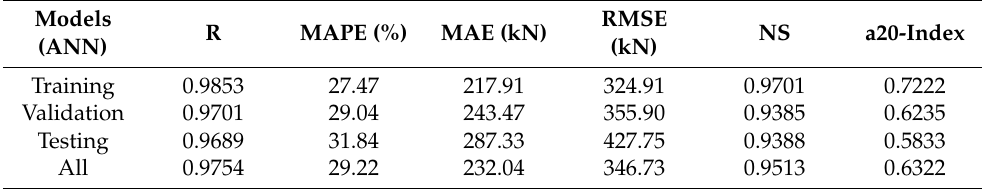
Table 6. Performance matrices of ANN model.